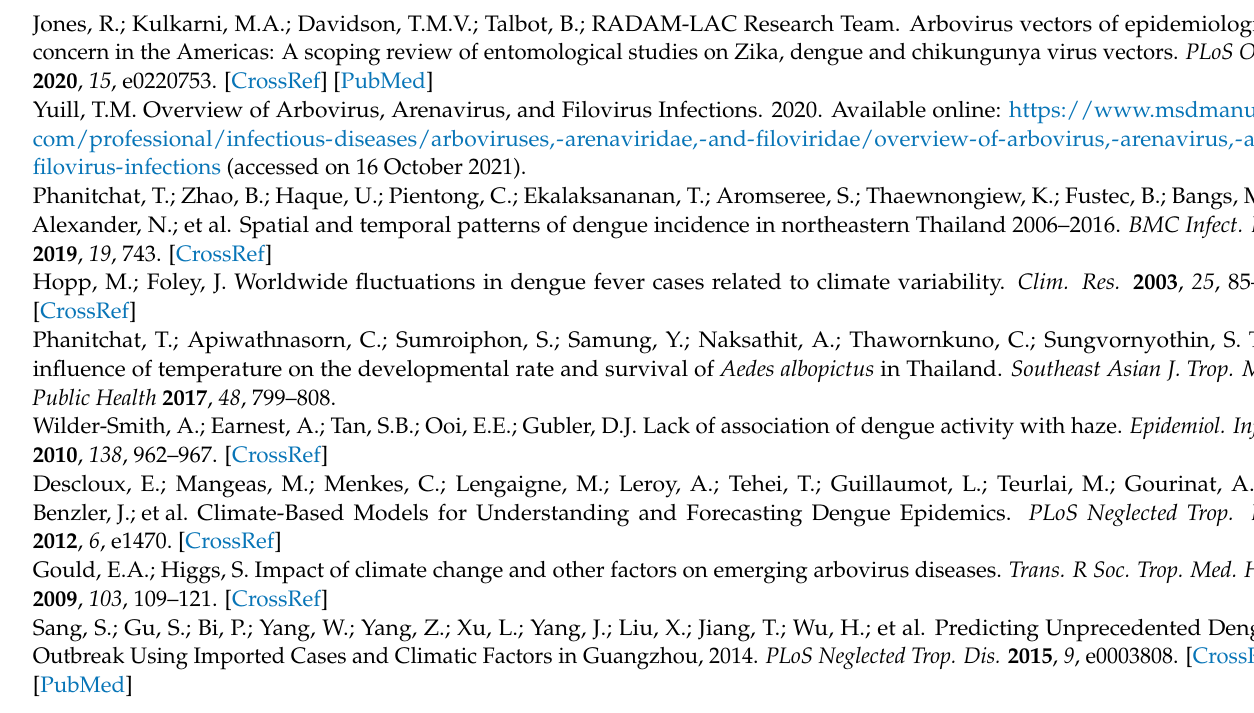
Figure S2. (Linear model of the dose–response relationship between PM 2.5 level and blood-feeding rate in female Ae. aegypti mosquitoes), Figure S3. (Three-segment piecewise linear model of the dose– response relationship between PM 2.5 level and blood-feeding rate in female Ae. aegypti mosquitoes), Figure S4. (Three-knot restricted cubic spline model of the dose–response relationship between PM 2.5 level and blood-feeding rate in female Ae. aegypti mosquitoes), Table S1. (Trace metal concentrations on the PM 2.5 filter